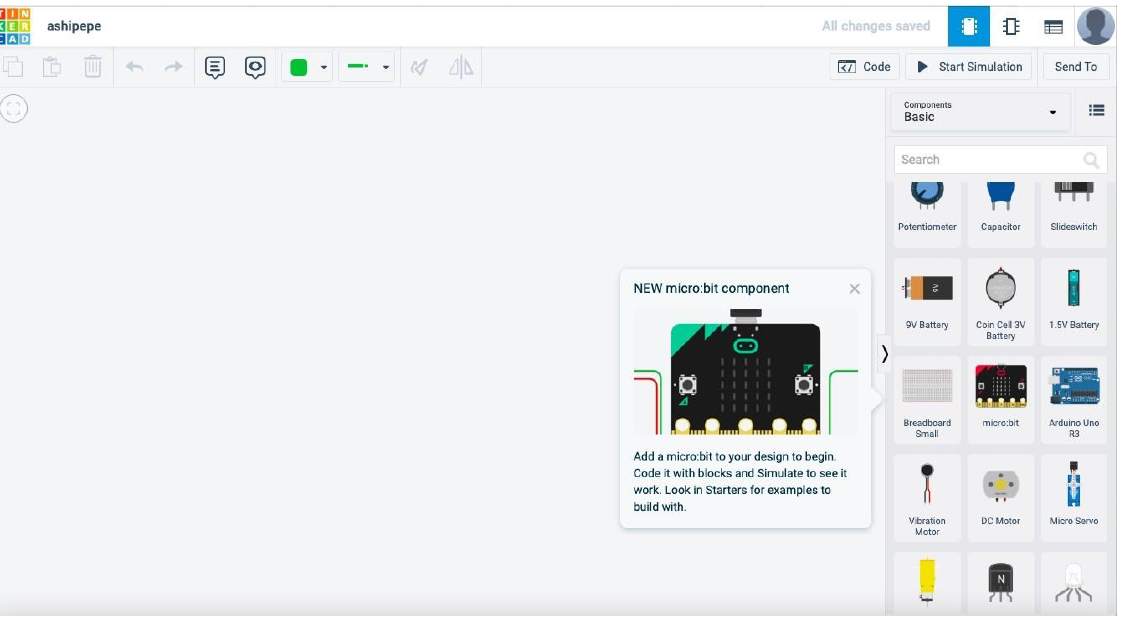
Figure 4. Tinkercad platform.